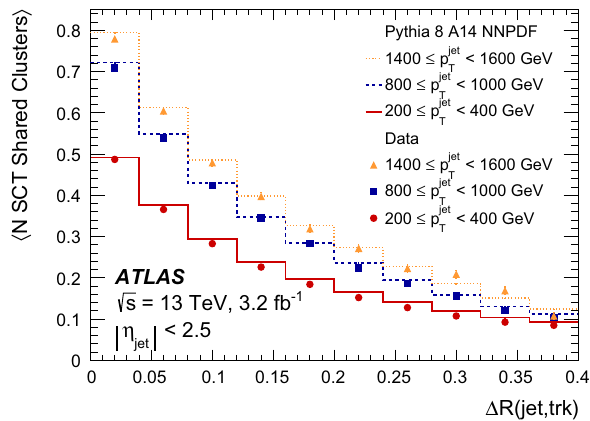
Fig. 6 The average number of IBL clusters on primary tracks (with a production vertex before the IBL) shown as a function of the angular distance of the track from the jet axis. Data (markers) and dijet MC (lines) samples are compared in bins of jet p T showing a slight drop at small distances explained by a residual cluster-to-track assignment inefficiency